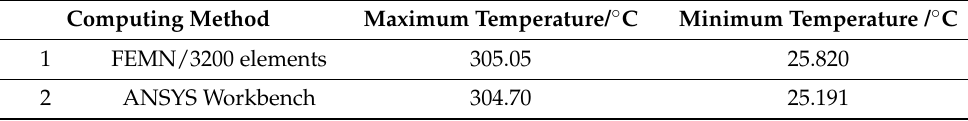
Table 6. Comparison of the upper and lower limits of the temperature field.